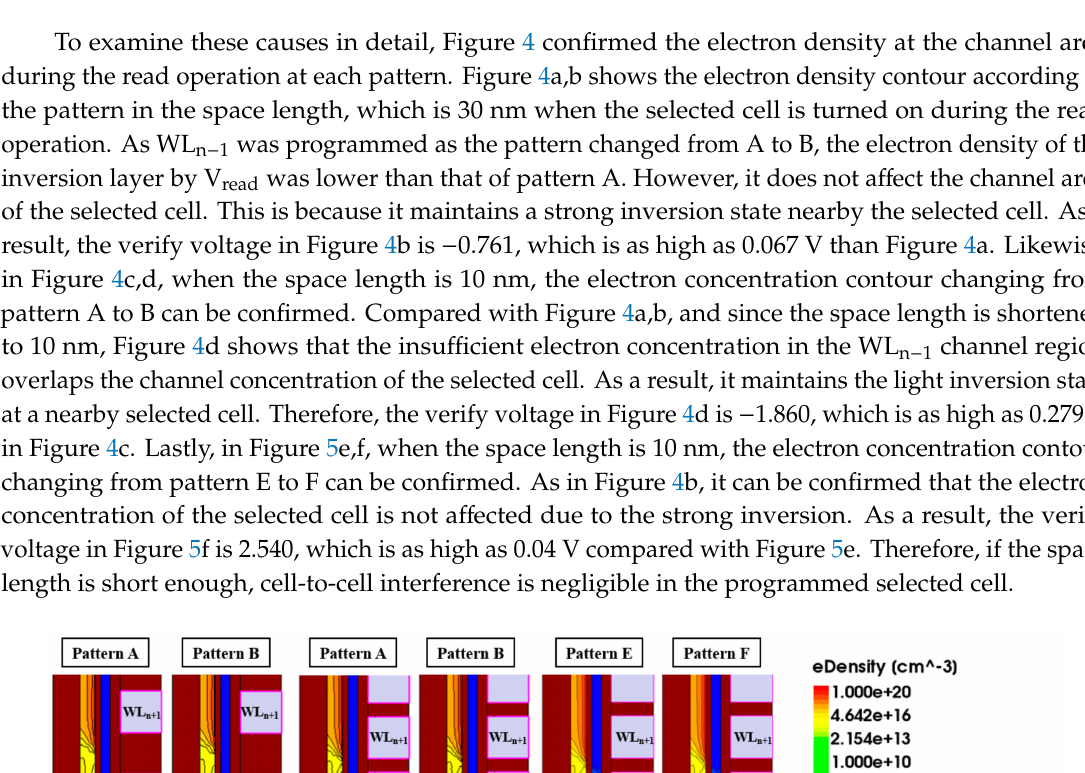
Figure 3. Conduction band diagram at the channel surface according to each pattern. ( a ) Gate length 30 nm, space length 30 nm; ( b ) gate length 30 nm, space length 10 nm.